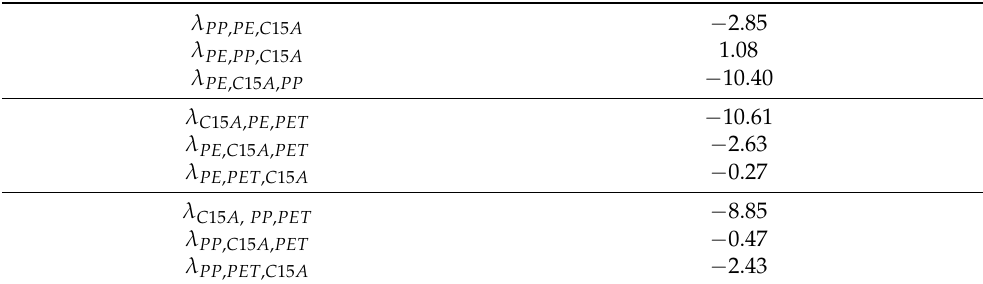
Table 3. Spreading coefficients (in mN/m) for ternary systems constituted by the three possible polymer pairs plus the